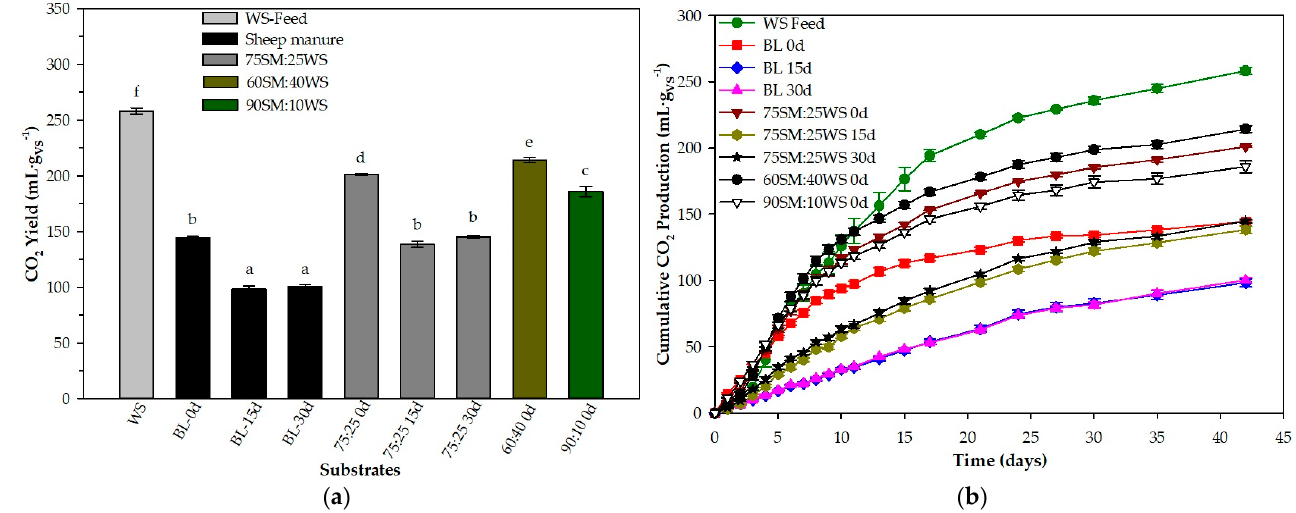
( p < 0.05) between the different tests. The bars designate the standard deviation.